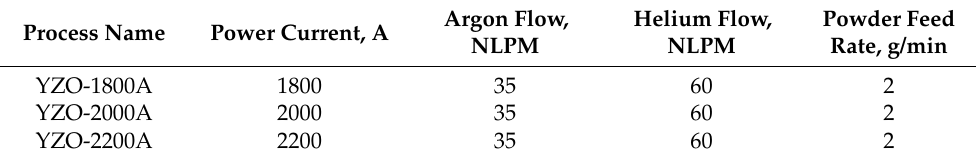
Table 1. Parameters used for production of ytterbium zirconate